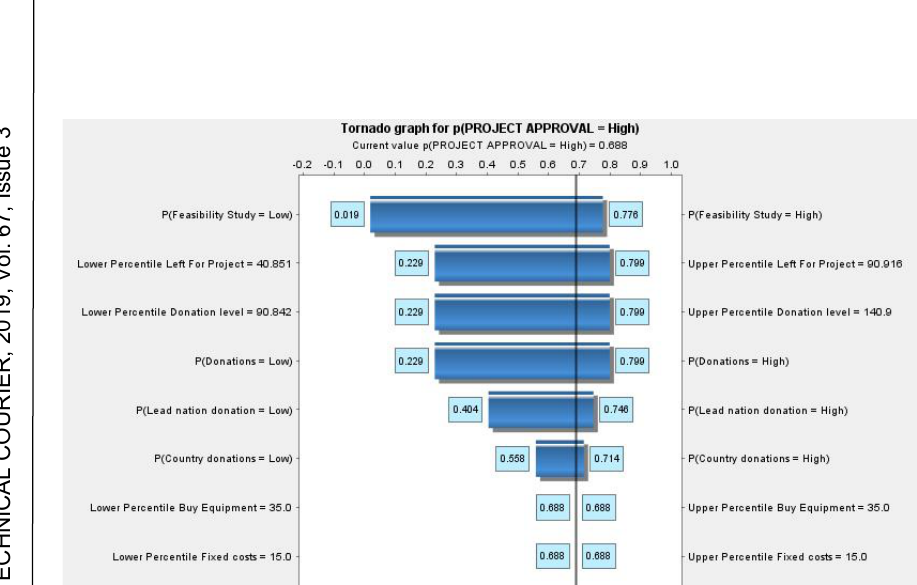
Figure 8 – Sensistivity data when the variable FS has the highest value (other variables have prior probabilities)